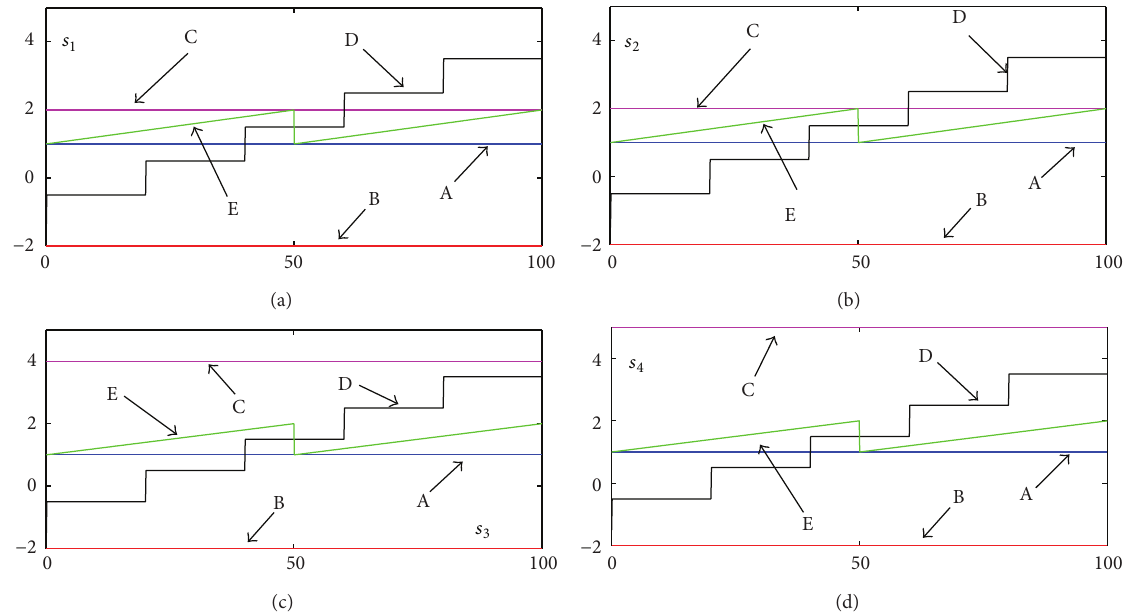
Figure 3: The five different cases of the parameters 𝑠 1 , 𝑠 2 , 𝑠 3 , and 𝑠 4 as function of time where Case A; {𝑠 1 ,𝑠 2 ,𝑠 3 ,𝑠 4 } = {1,1,1,1} Case B; , 𝑠 , 𝑠 , 𝑠 } = {−2, −2,−2, −2} Case C; {𝑠 {𝑠 1 2 3 4 s 1 = s 2 = s 3 = s 4 = 1 + ( fraction part of ( t /50))/50